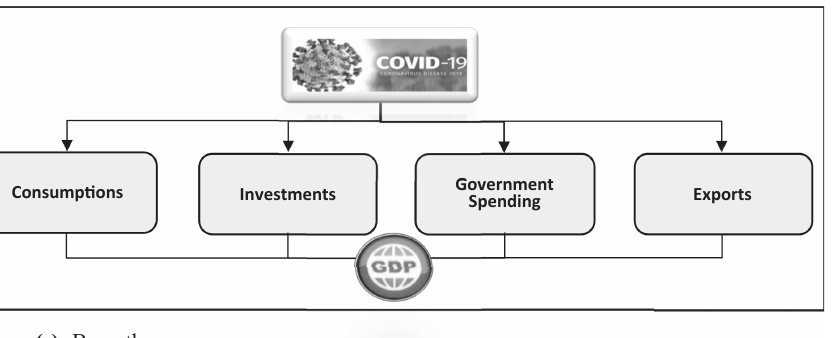
Figure 2. The impacts of COVID- 19 on GDP